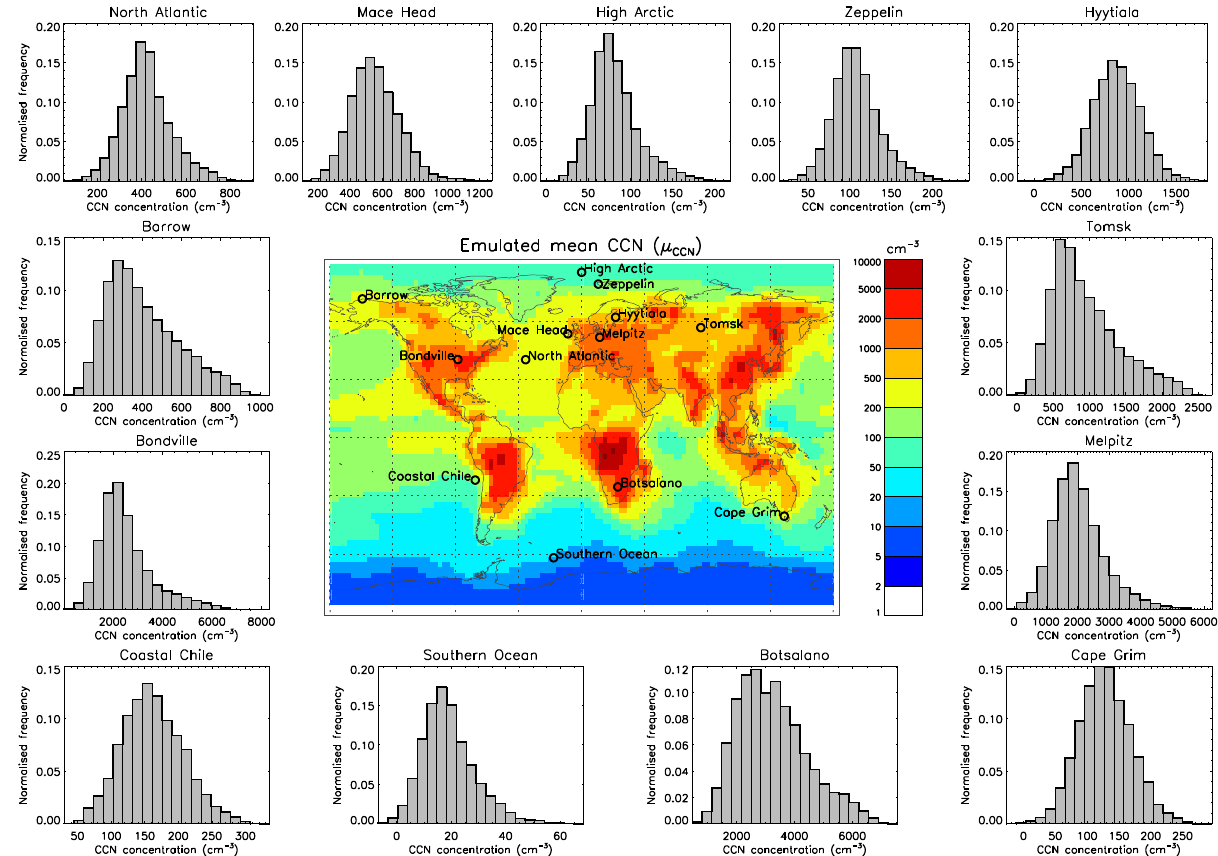
Fig. 6. The frequency distribution of CCN concentrations across the 28-dimensional parameter uncertainty space simulated from the emu- lators. Distributions are shown for July for 13 model grid boxes corresponding to the locations in Sect. 6.3.6 and Fig. 9. The map of mean CCN is the same as in Fig. 5. In some cases the CCN concentration is negative when in reality it will be truncated at zero meaning that the uncertainty in some places will be slightly overestimated. Since the negative CCN is confined to a small region of the parameter uncertainty space, the sensitivity analysis results will be robust to the negative values. Emulator calibration is not part of this study, but the first regions of parameter space to be removed will be those that give negative